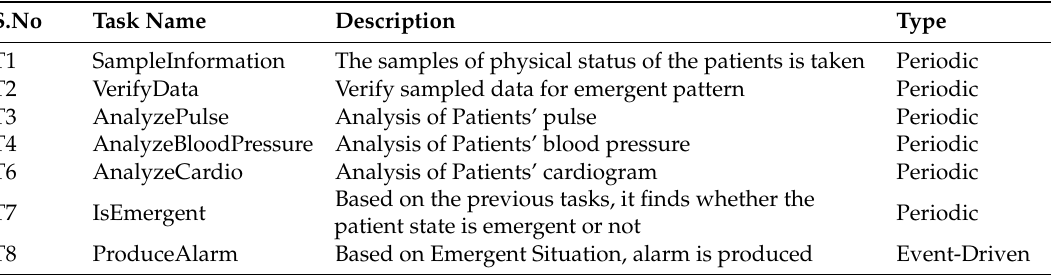
Table 1. Real-time tasks related to a Patient Monitoring System in an IoT-based SmartHealth Domain.